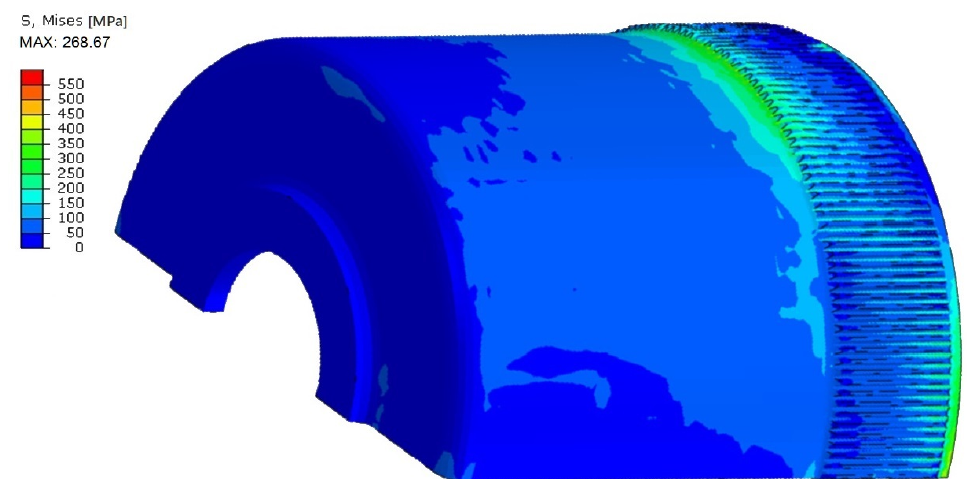
Figure 5. The distribution of the stresses in the flexspline base model—variant I.